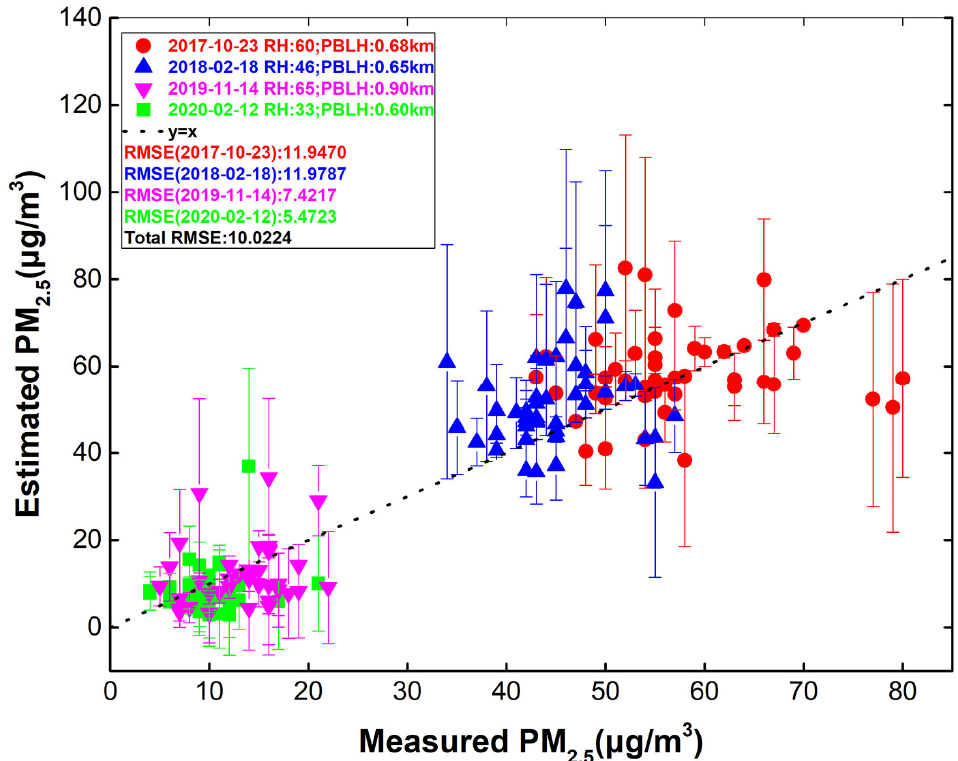
Figure 10. PM 2.5 absolute error diagram between ground monitoring station measurements and estimated results for a certain day in different years.